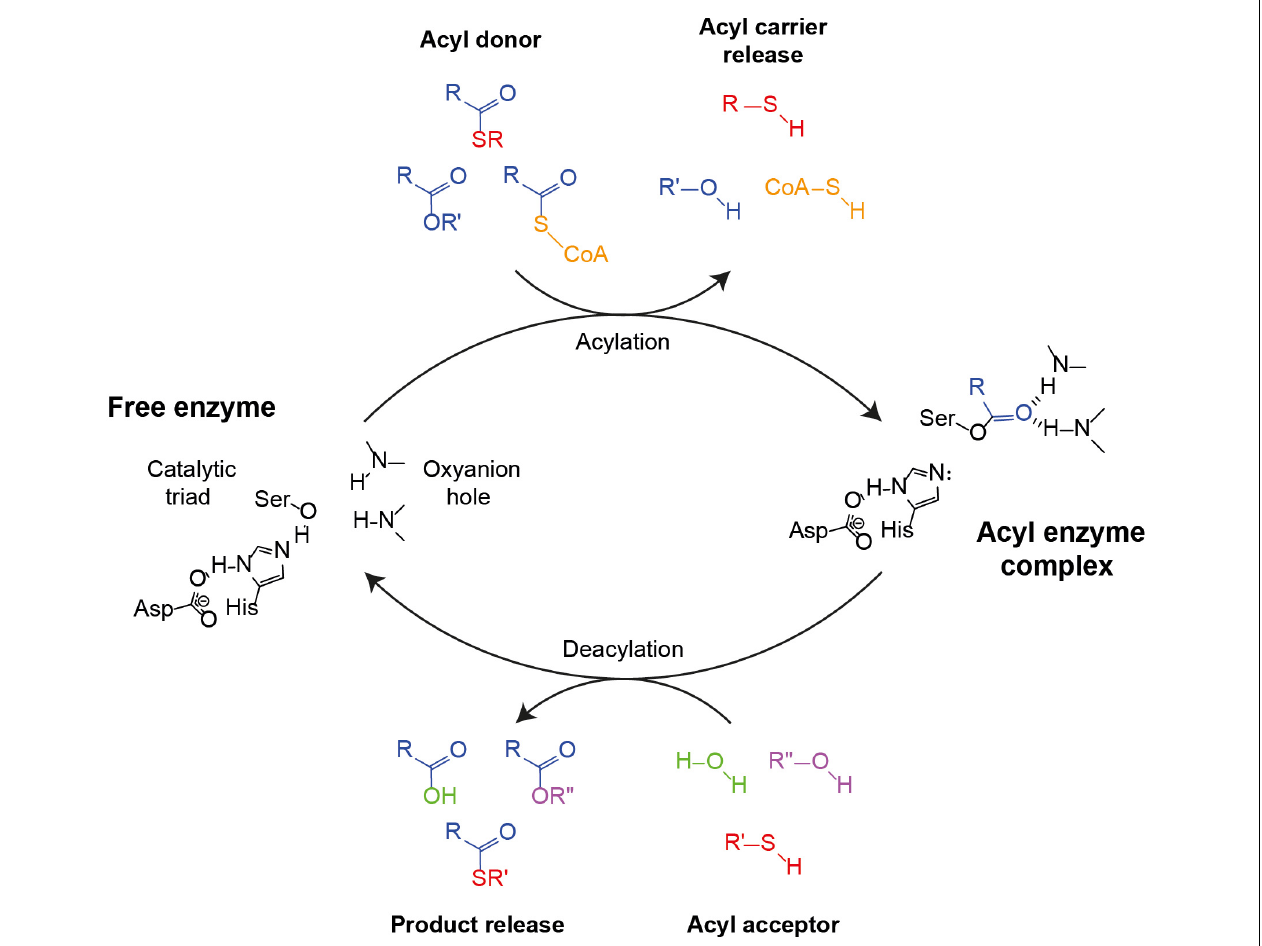
FIGURE 2 | Canonical esterase mechanism demonstrating AAT, hydrolysis, alcoholysis or thiolysis reactions. The catalytic triad (Asp–His–Ser) along with the oxyanion hole (two amide N-Hs) are indicated in the free enzyme state (left). The first step of the cycle is the binding of the acyl moiety of an acyl-CoA, an ester or a thioester (colored yellow, blue, or red, respectively), followed by acylation and the release of the acyl carrier and the formation of the acyl enzyme complex (right). Next, depending on whether an alcohol or a thiol is present in the aqueous medium, hydrolysis, ester formation or thioester formation may occur. In the case of esterase or thioesterase, water (green) binds to the acyl enzyme complex, causing the release of the acid and the restoration of the free enzyme state. In the case of AAT or alcoholysis, an alcohol (magenta) binds to the acyl enzyme complex, which causes the release of an ester. The difference between AAT and alcoholysis is defined by the acyl carrier molecule as a CoA or an alcohol, respectively. Likewise, if a thiol (red) nucleophile is present, the product of the cycle will be a thioester.